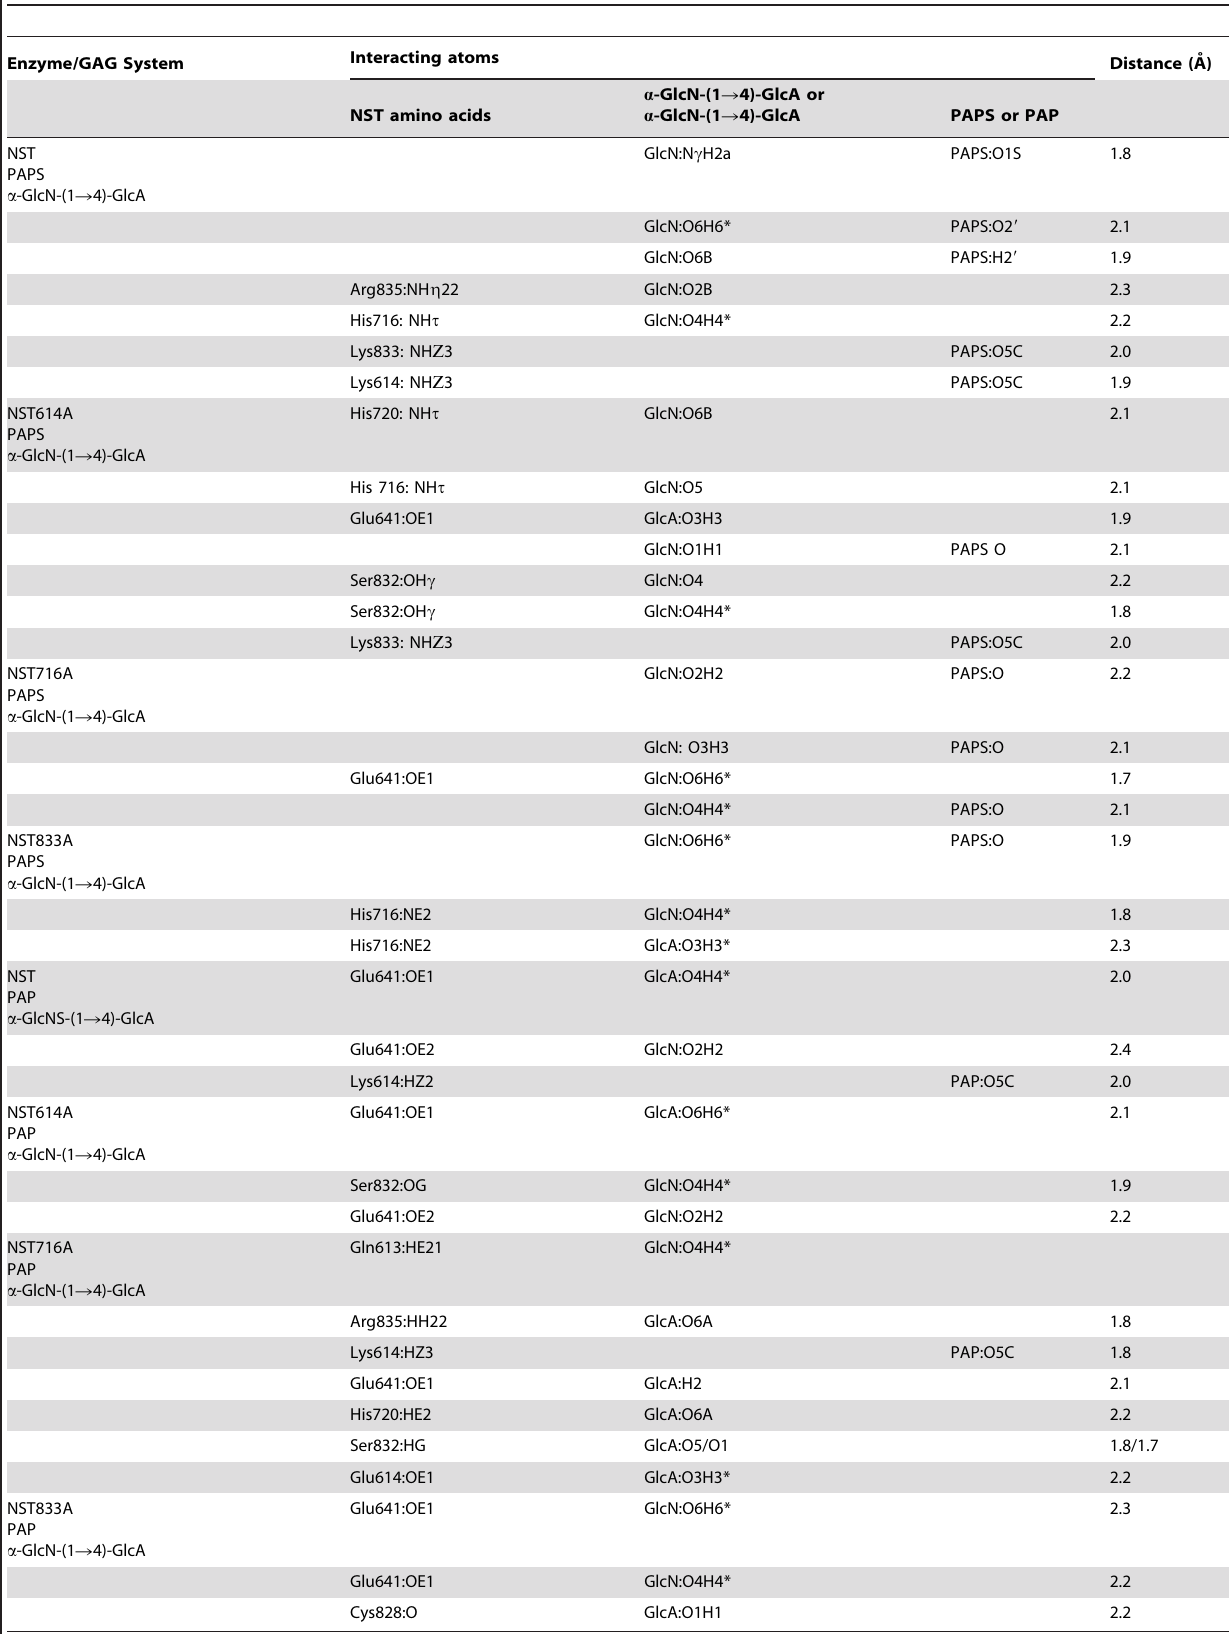
Table 1. N-sulfotransferase 1 and mutants docking energies and hydrogen bond